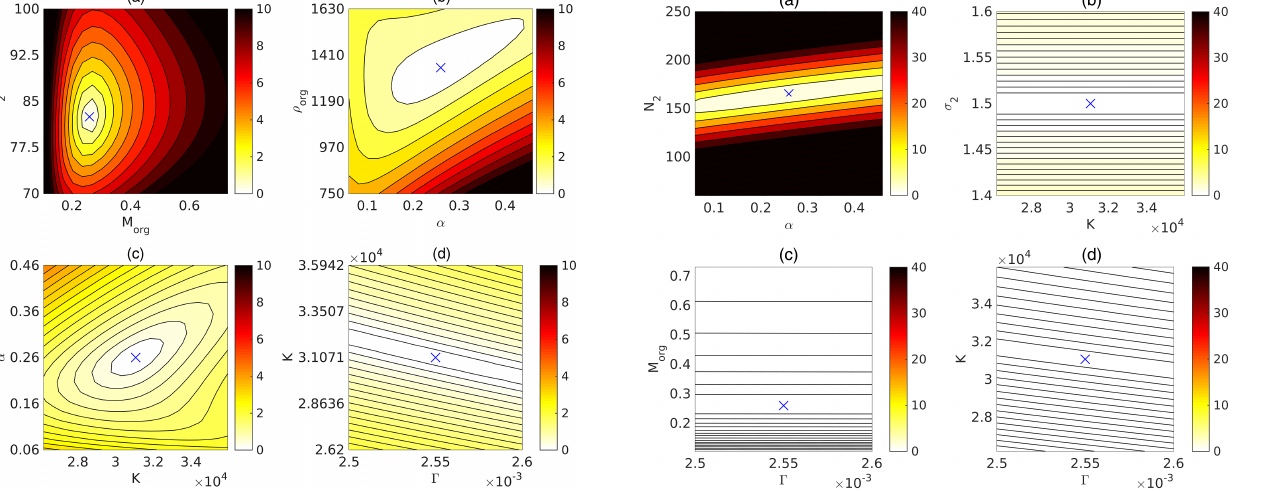
Figure 10. Response surfaces for a p w σ nf in the marine average en- vironment. Blue crosses indicate the true parameter values θ true used to calculate the calibration data. The colour scale represents the value of the OF calculated for the modelled spectra against the calibration data for parameter values across the uncertainty ranges (Table